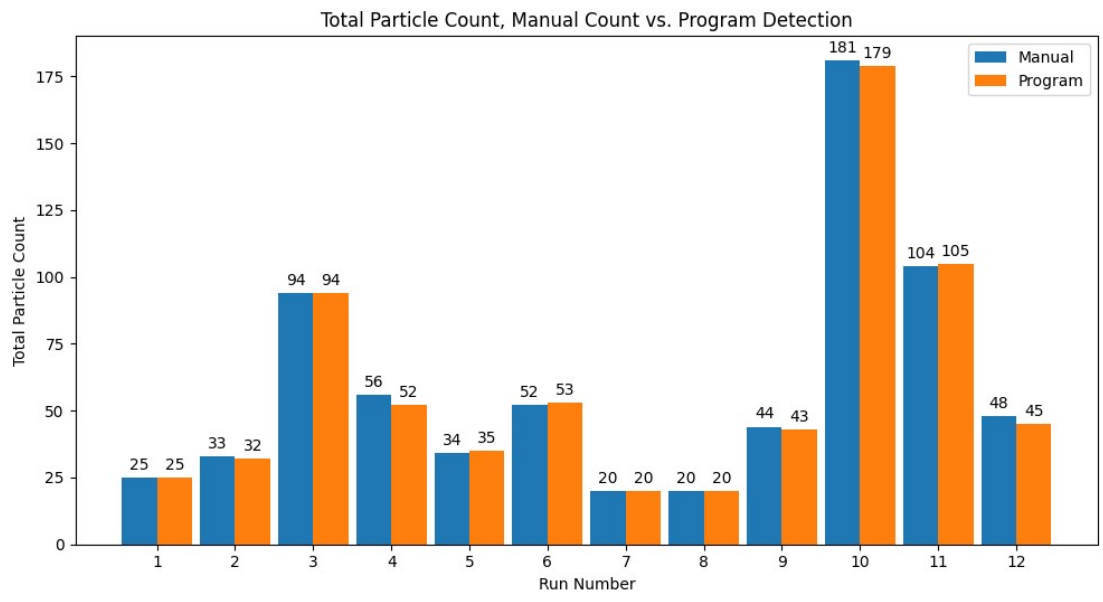
Figure 7. The total particle count of the program versus the manual count for the 12 manually analyzed videos (run number) with 10 µm diameter.